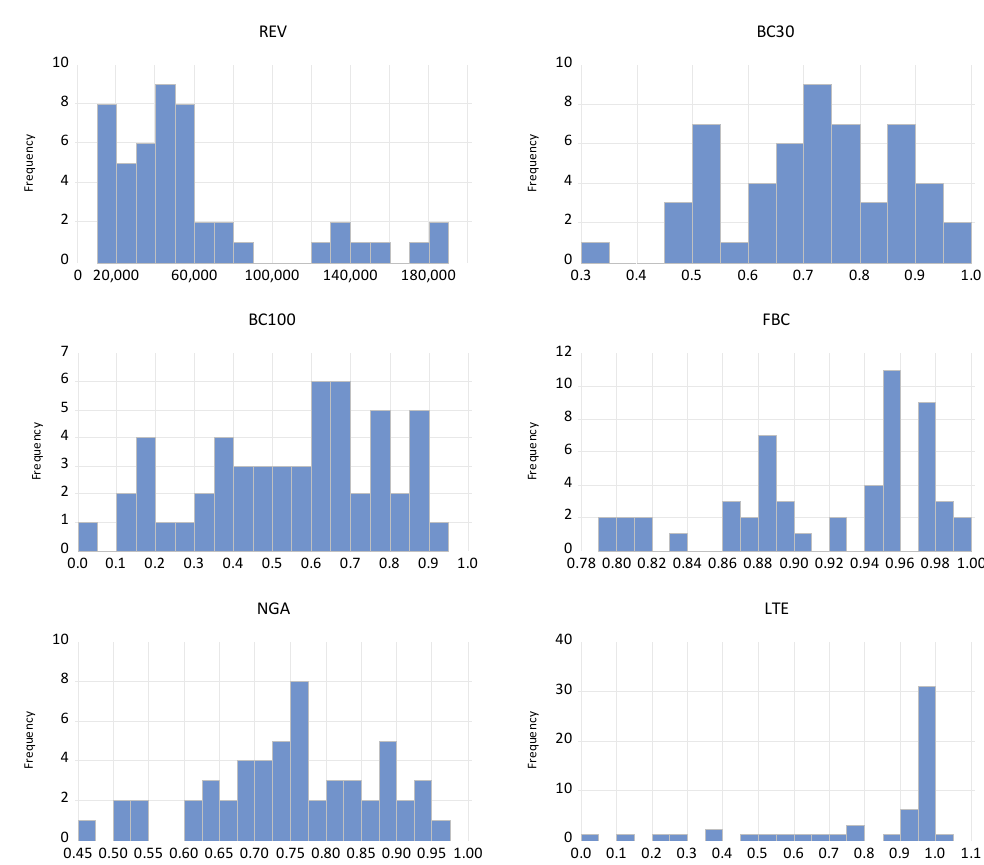
Figure 4. Variables’ outliers and breakdown points.